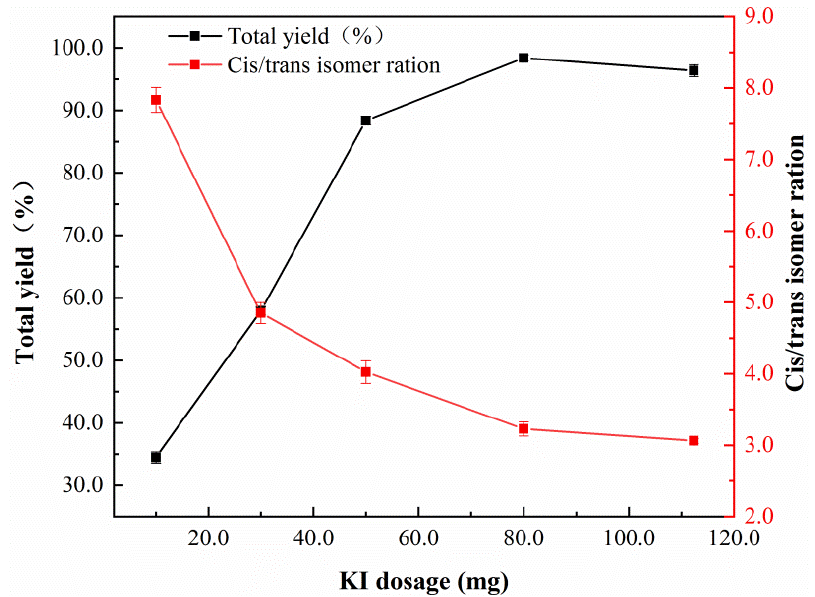
Figure 9. Effects of KI dosage on the nano-Fe/Pd catalyst activity in the reaction. Reaction condi- tions: catalyst (10 mg), acetylene (11 mmol), MeOH (20 mL), P CO = 1.8 MPa, P total = 4.0 MPa, T = 323.2 K, t = 8 h.